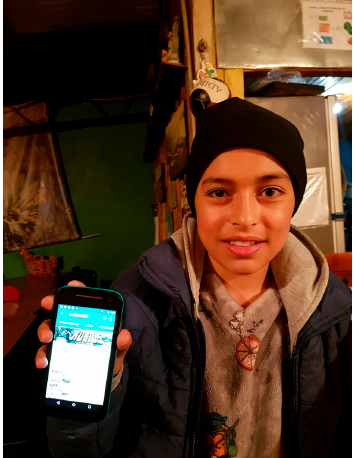
Figure 1. Colombian child using elRubius’ YouTube channel, one of the most popular in Ibero-American countries. San José de Sumapaz (Colombia). © the author 2016.